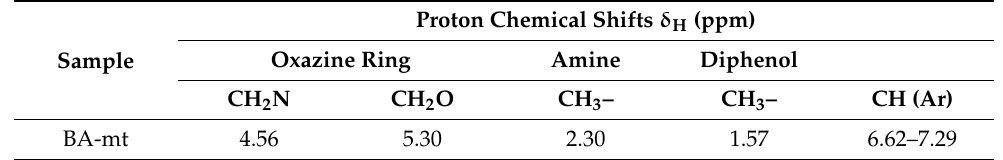
Table 3. The results of 1 H NMR spectroscopy of BA-mt.